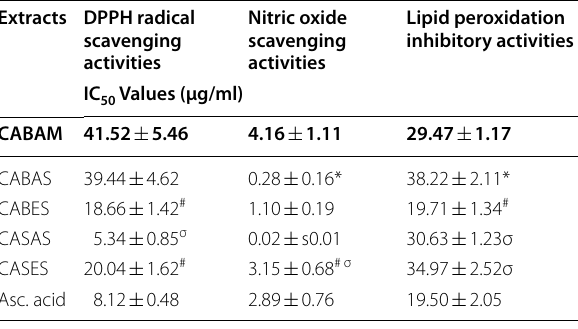
Values represent Mean # p < 0.05 versus acetone; σ p < 0.05 versus Bark